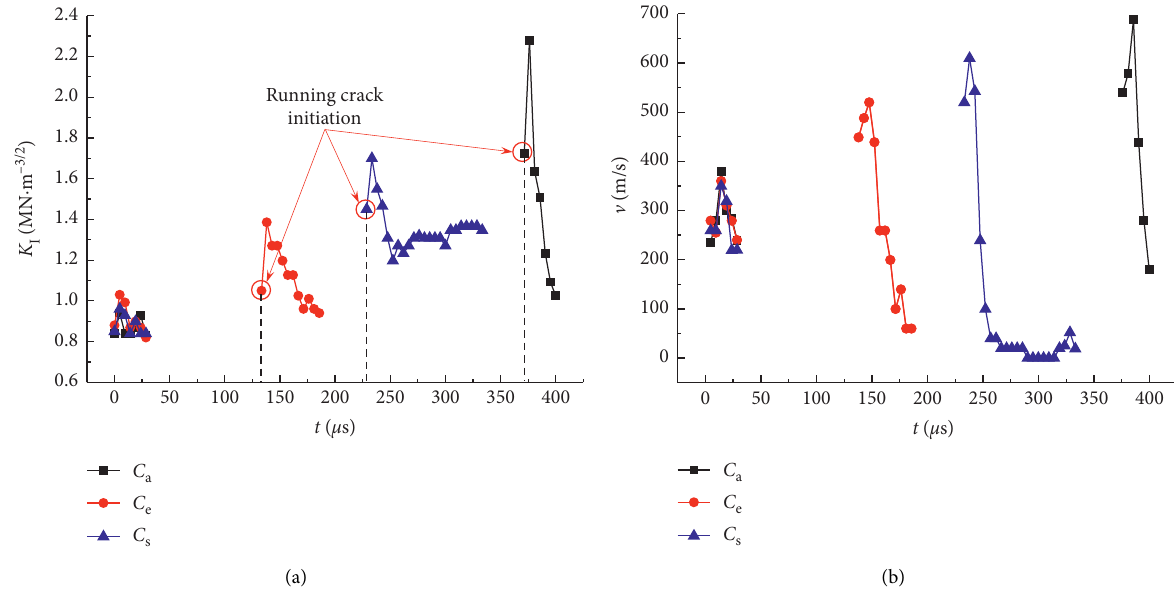
Figure 7: Changing curves of the dynamic mechanical parameters of the running crack with time in the circular defect group. (a) K (b) v − t .